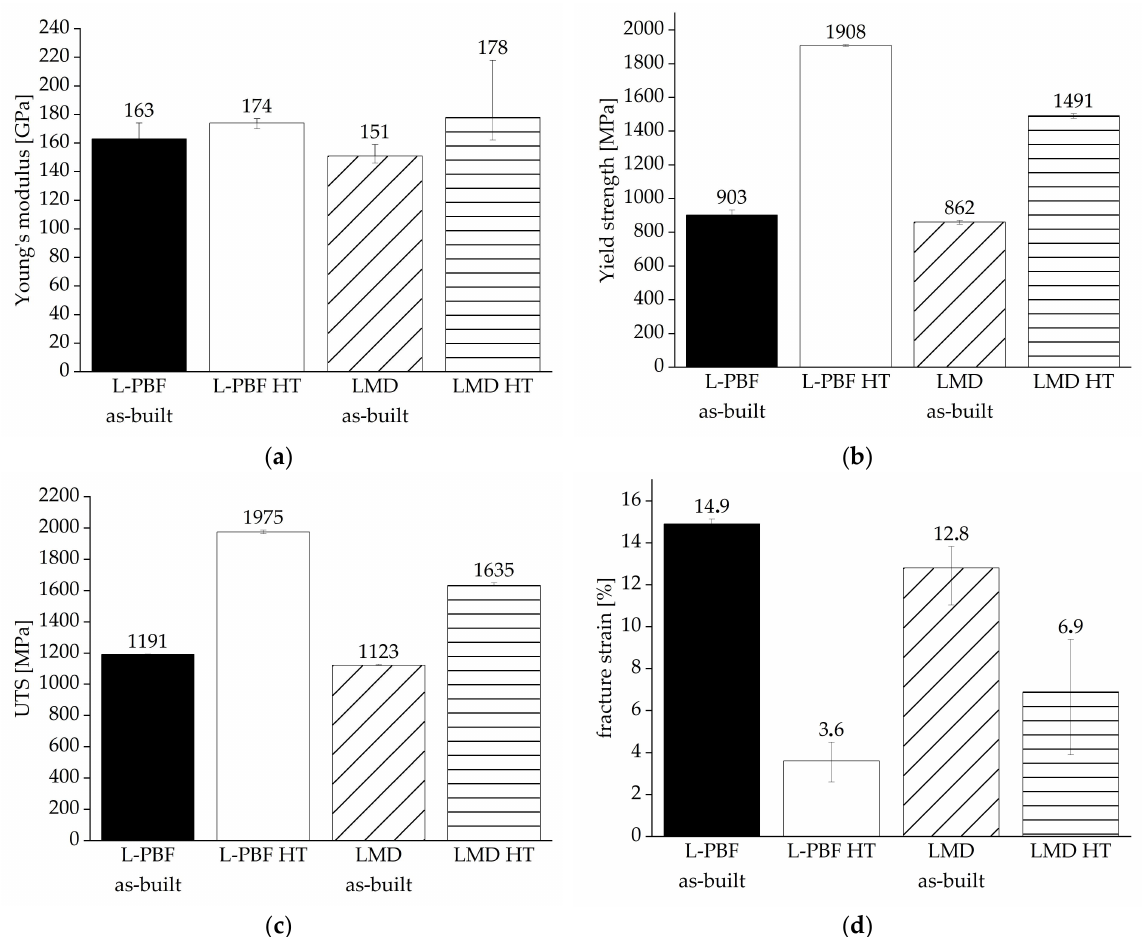
Figure 11. Average mechanical properties of the samples fabricated by L-PBF and LMD state as-built and heat-treated by quasi-static tensile testing. Five samples for each combination of manufacturing process and state. ( a ) Young’s modulus; ( b ) yield strength; ( c ) ultimate tensile strength (UTS); ( d ) fracture strain.